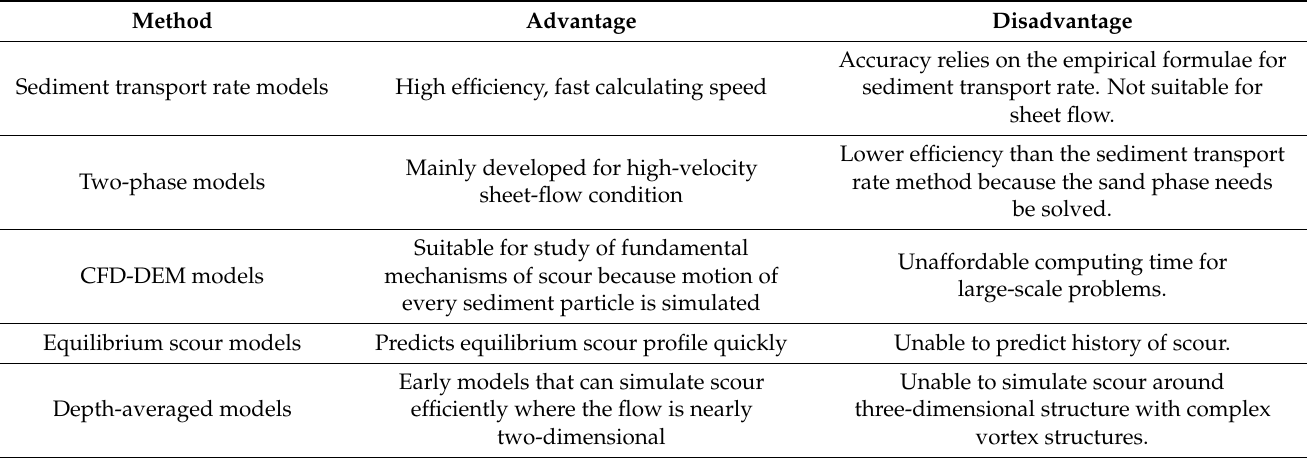
Table 1. Comparison between different scour